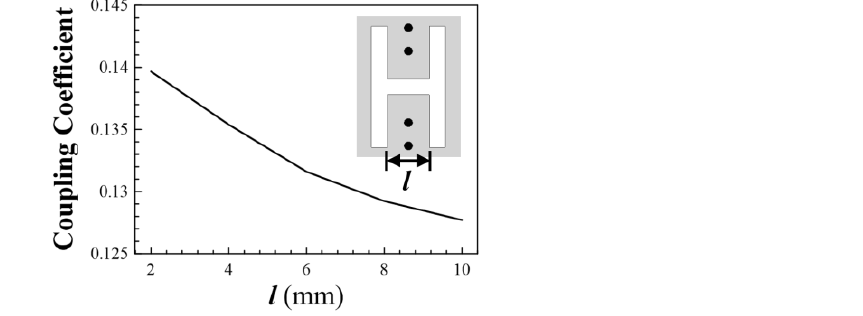
Figure 9. The coupling coefficient between resonators 1 and 2 as a function of the dimension l in the H-shaped slot.